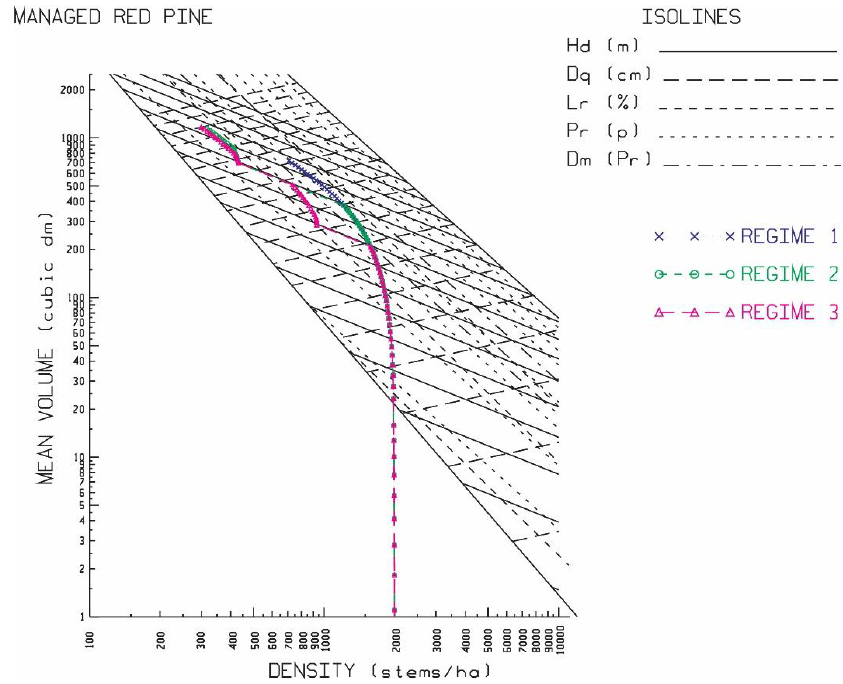
Figure 4. Temporal size – density trajectories for the three red pine plantations growing under con- ditions consistent with the RCP8.5 (Table 1) on a medium-to-good site quality ( S I = 23) situated in north-western Ontario (Thunder Bay) as illustrated within the context of the SDMD graphic. Graph- ical denotations and regime specifics follow those defined in Figure 2 and Table 2, respectively.